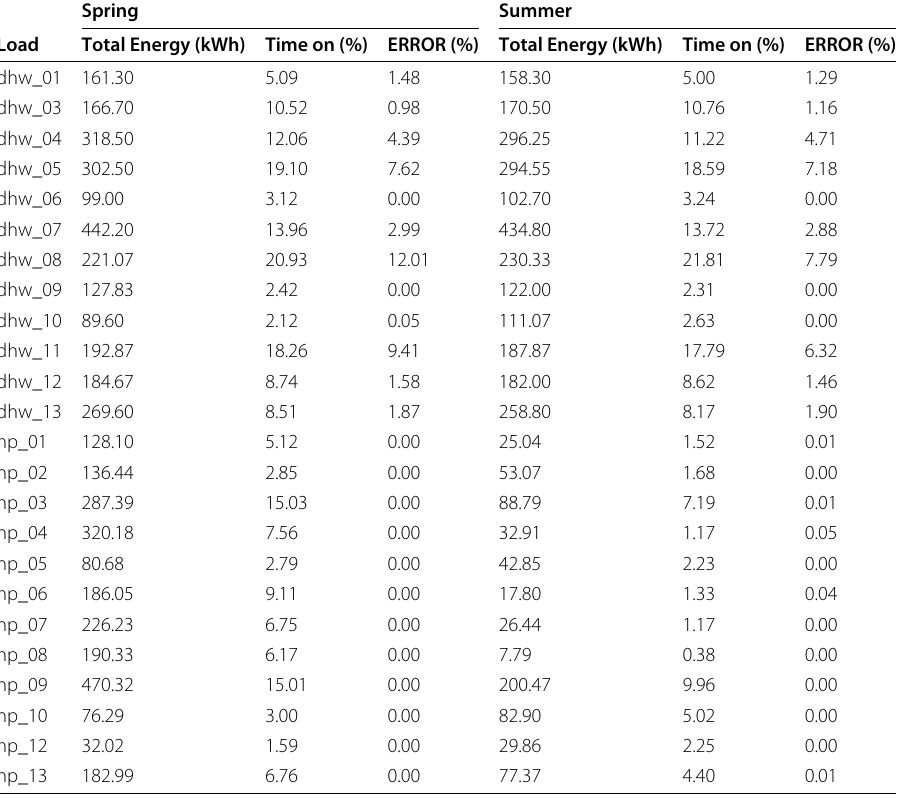
Table 4 Non intrusive load monitoring - spring and summer periods Spring Summer